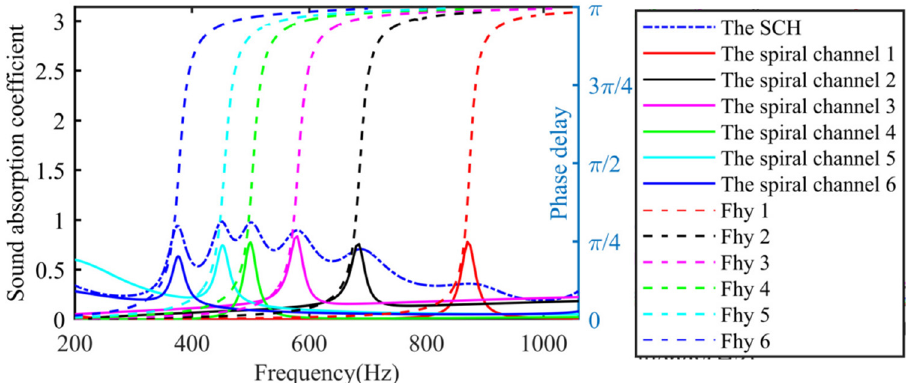
Figure 6. Contrast of the sound absorption coefficient and the phase delay in the MSC-AM, in which the dashed lines represent the curves of phase delay of the single spiral chamber, the solid lines represent the curves of sound absorption coefficient of the single spiral chamber, and the dot-dashed lines represent the curves of total sound absorption of the MSC-AM, respectively.